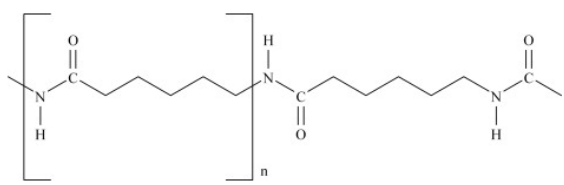
Figure 6. The chemical structure of PA6.